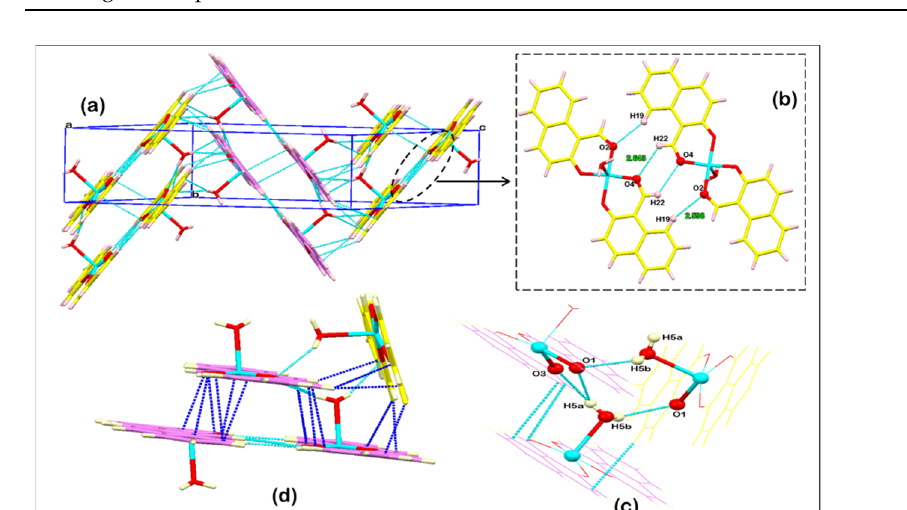
Figure 2. ( a ) Crystal packing and insight view of ( b ) C-H...O interaction, ( c ) O-H...O interaction, and ( d ) C-H... π and C-H...O